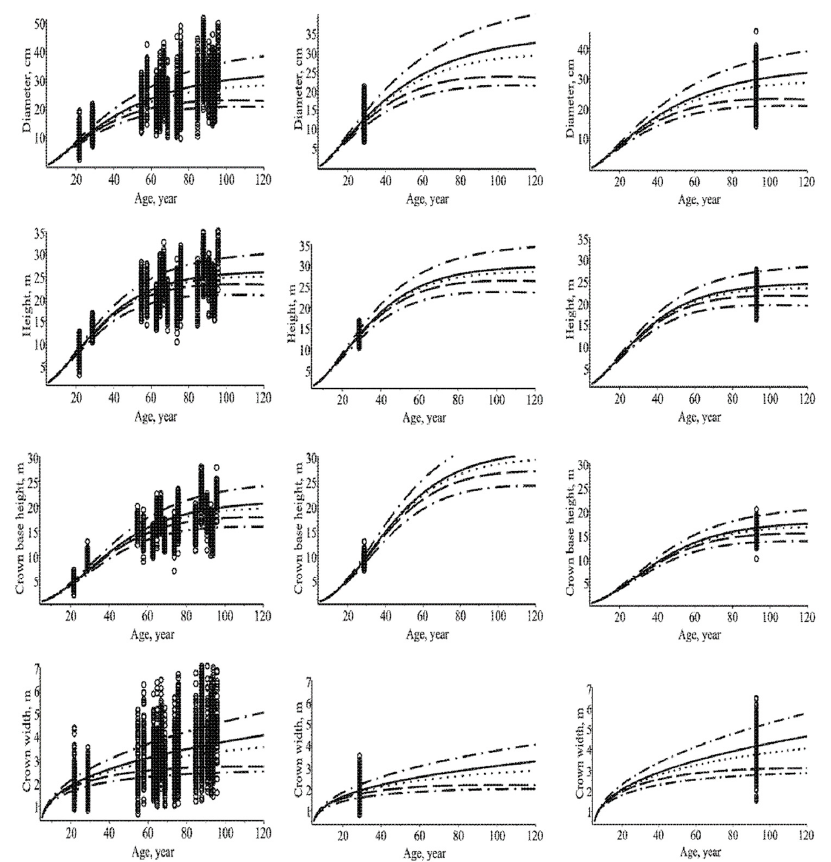
Figure 7. Evolution of the marginal mean, mode, median and both quartiles (Equations (9)–(12)) within the observed datasets: mean—solid line; median—dotted line; mode—dashed line; quartiles—dashed–dotted line; first column—fixed effect scenario; second column—mixed effect scenario and first randomly selected stand; and third column—mixed effect scenario and second randomly selected stand.